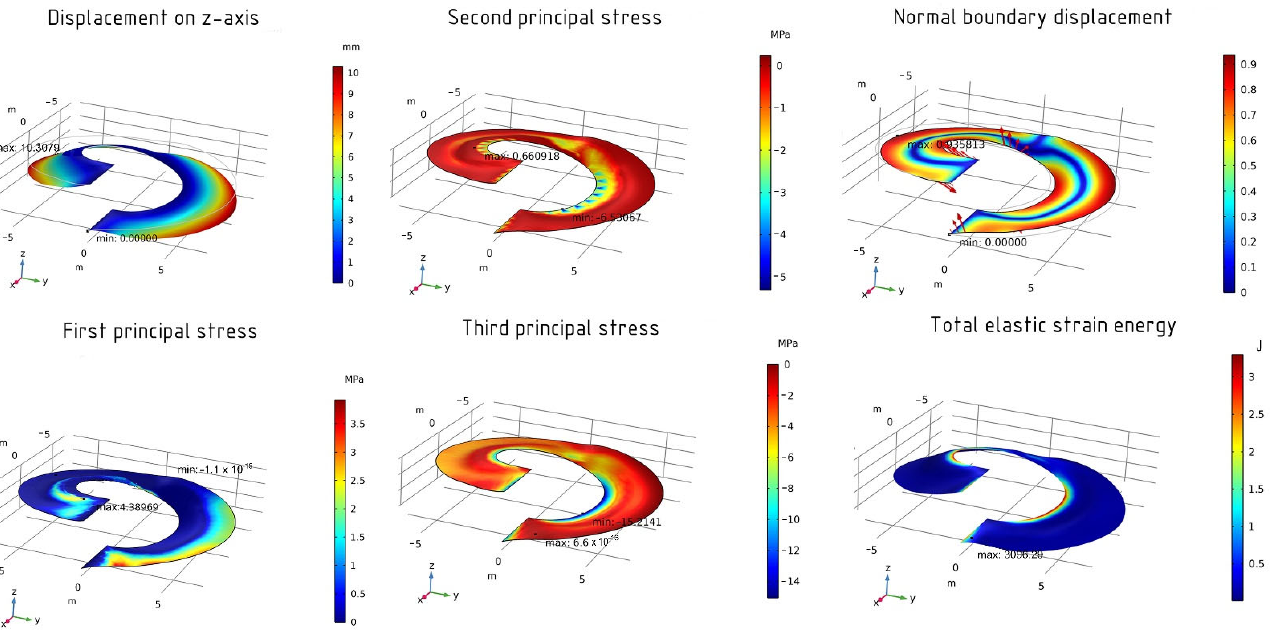
Figure 17. The results of the optimized shell using the MMA method.